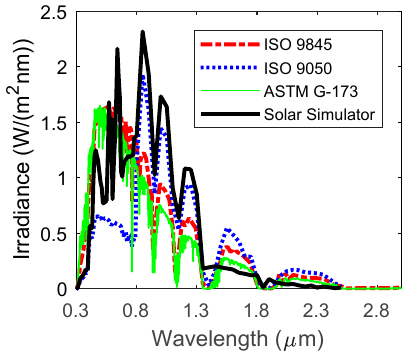
Figure 9. Solar simulator radiation spectrum and reference AM1.5 spectra.